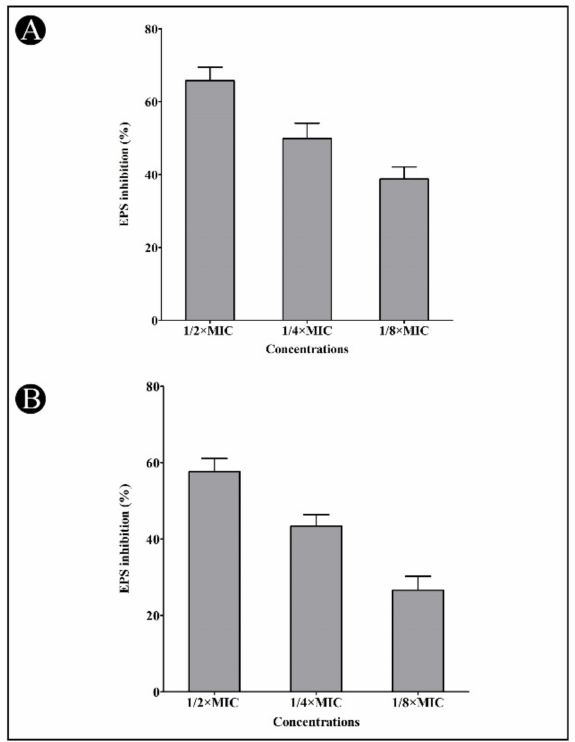
Figure 8. Inhibition of EPS production by synthesized AgNPs at the sub-MIC concentration. ( A ) Effect of synthesized AgNPs on EPS production in C. violaceum at the sub-MIC concentrations (1/2, 1/4 and 1/8 MIC). ( B ) Effect of synthesized AgNPs on EPS production in P. aeruginosa at the sub-MIC concentrations (1/2, 1/4 and 1/8